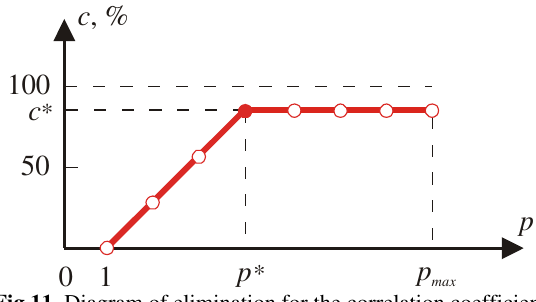
Fig 11. Diagram of elimination for the correlation coefficient